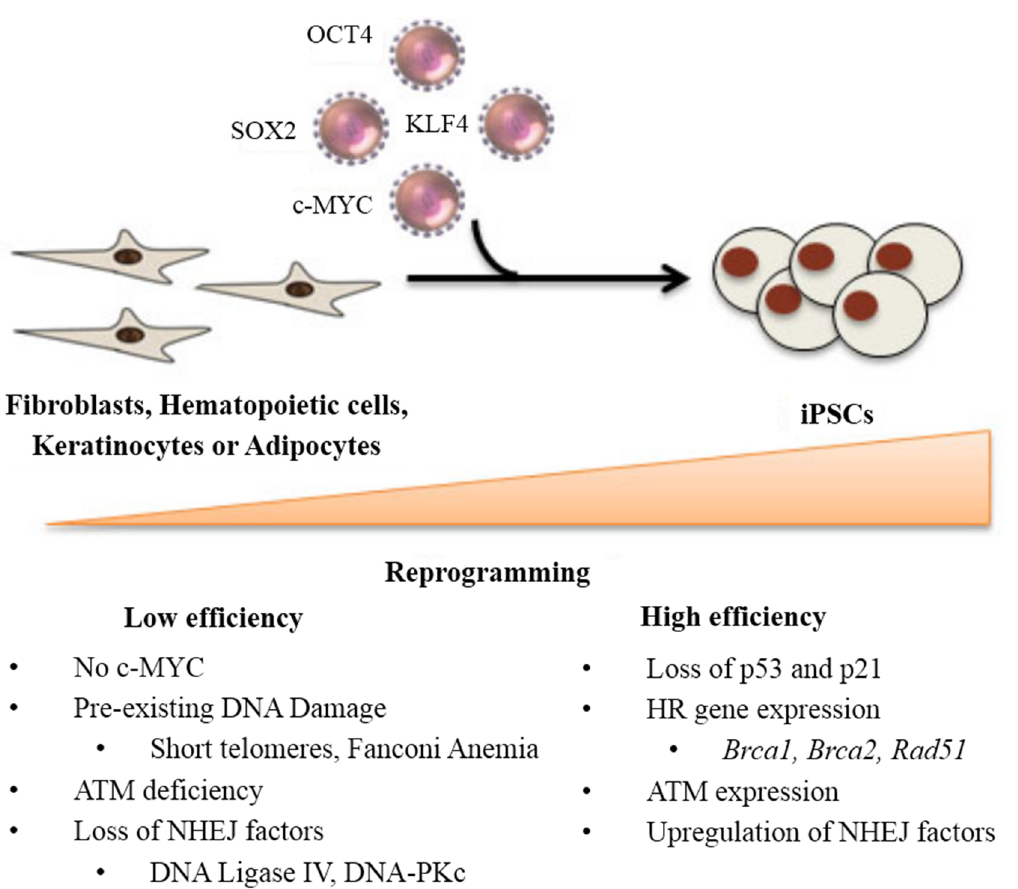
Figure 1. DNA damage factors that govern reprogramming efficiency from the somatic cell state to the pluripotent state are summarized. High efficiency is achieved with downregulation of apoptotic factors including p53 and upregulation of DNA repair genes (homologous recombination (HR) and non-homologous end joining (NHEJ)). Pre-existing DNA damage in combination with low DNA repair capacity leads to low